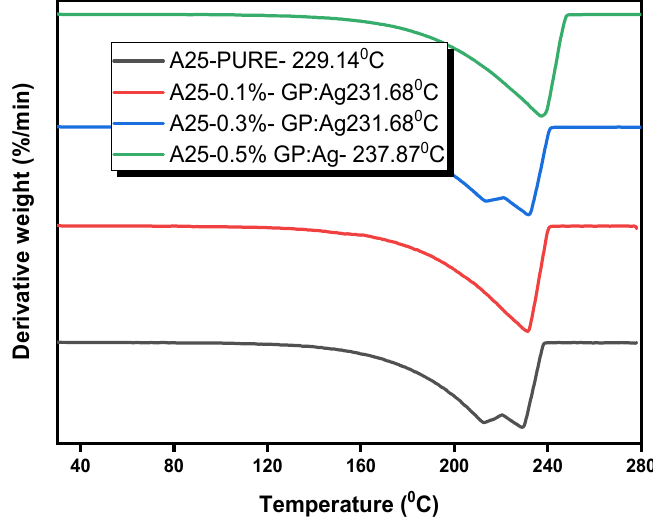
Figure 6. TGA thermograms of A25 and hybrid nanocomposites. Table 3. Thermal stability parameters of hybrid nanocomposites.